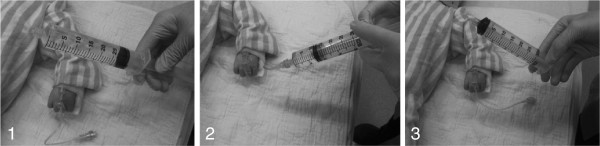
The ‘disconnect-reconnect’ technique for rapid fluid resuscitation. This method involves (1) connecting a fluid filled syringe to the IV extension tubing, (2) administering the fluid manually, and then (3) disconnecting the empty syringe, thus allowing for connection of another ready syringe that has been filled with fluid by an assistant, and repeating until fluid delivery is completed.